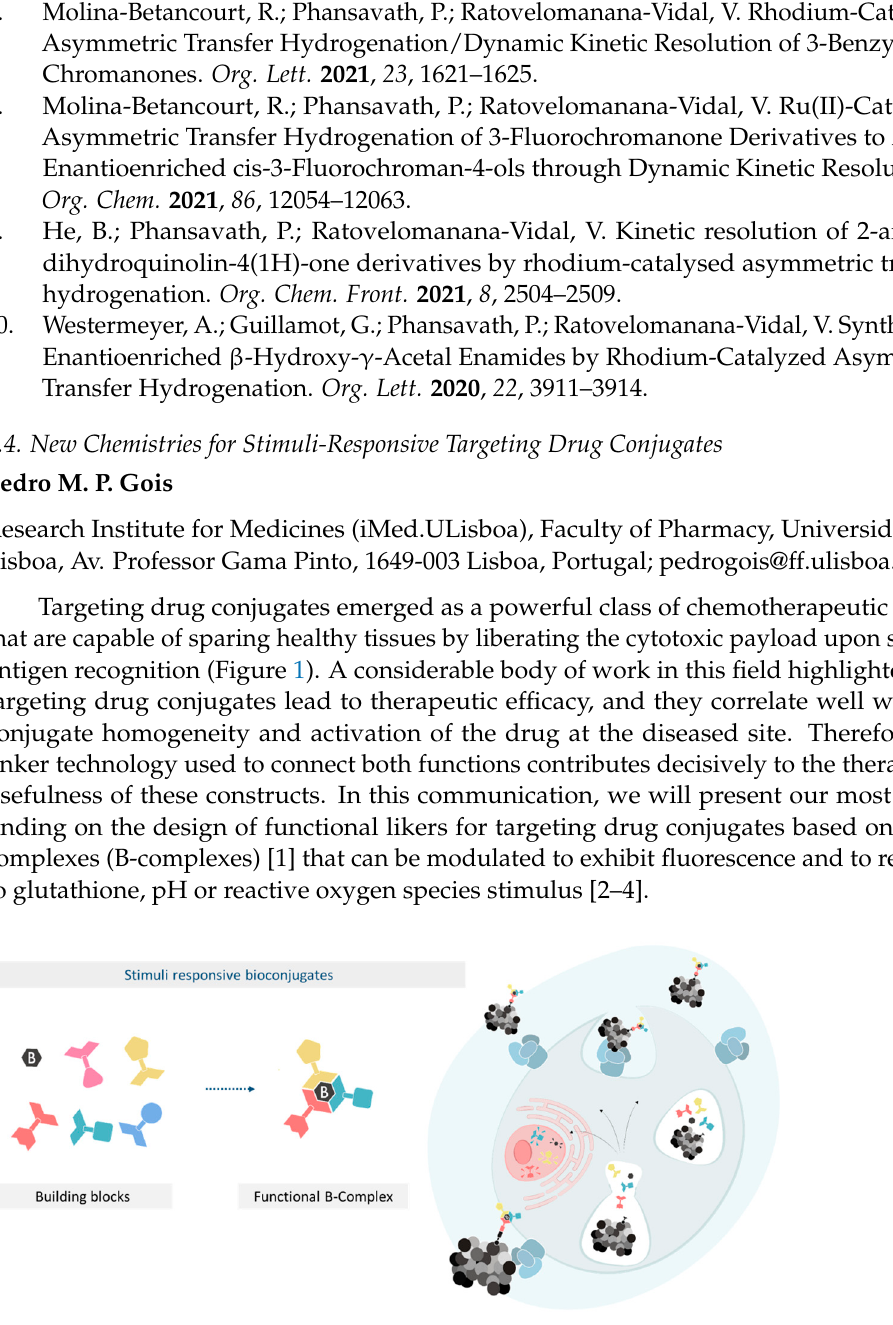
Figure 1. Modular, stimuli-responsive targeting drug Figure 5. Modular, stimuli-responsive targeting drug conjugates.